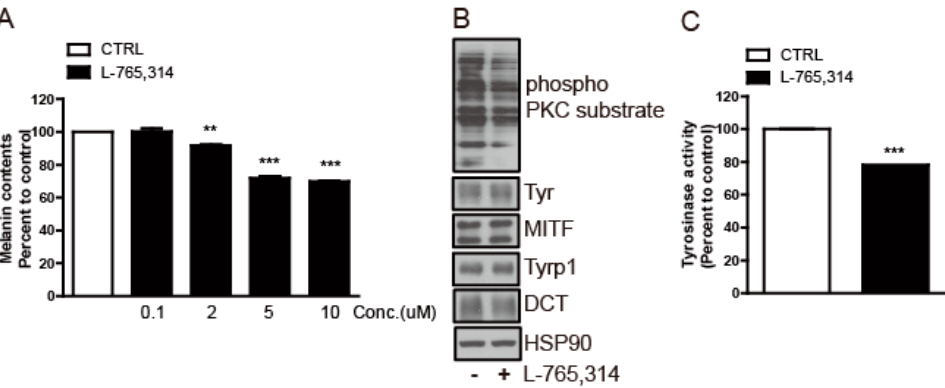
Figure 7. L-765,314 suppressed melanogenesis in normal human melanocytes. ( A ) Melanin contents of normal human melanocyte (NHM) cells treated with 0.1–10 μ M L-765,314 for 96 h. ( B ) PKC and ( C ) tyrosinase activity of NHM cells after incubation for 96 h with 10 µ M L-765,314. ** and *** represents p < 0.01 and p < 0.001,